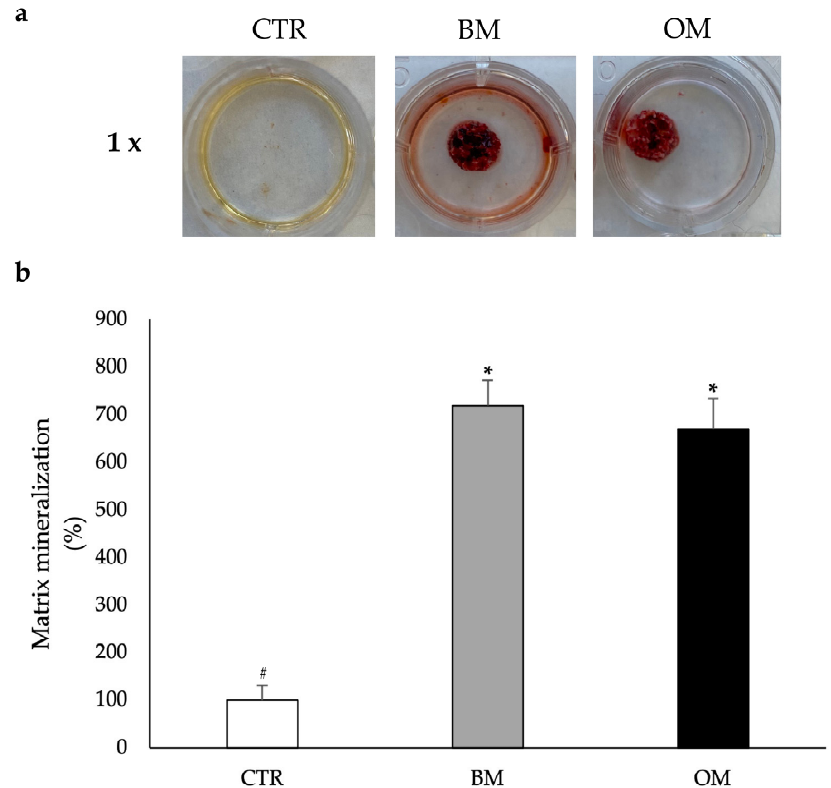
Figure 4. Osteogenic di ff erentiation analysis of CGF primary cells grown on the HA-Si sca ff old after 21 days of incubation. The CTR consists of CGF primary cells without HA-Si scaffold incubated in BM. Primary cells released from CGF were cultured on the scaffolds in BM or OM. ( a ) Photographs at 1 × magnification. ( b ) Percentage of matrix mineralization of the three conditions normalized with DNA concentration. Data are represented as mean ± SD of triple measurements from three independent experiments. Samples bearing di ff erent symbols (#, *) di ff er signi fi cantly ( p < 0.05; one-way ANOVA).